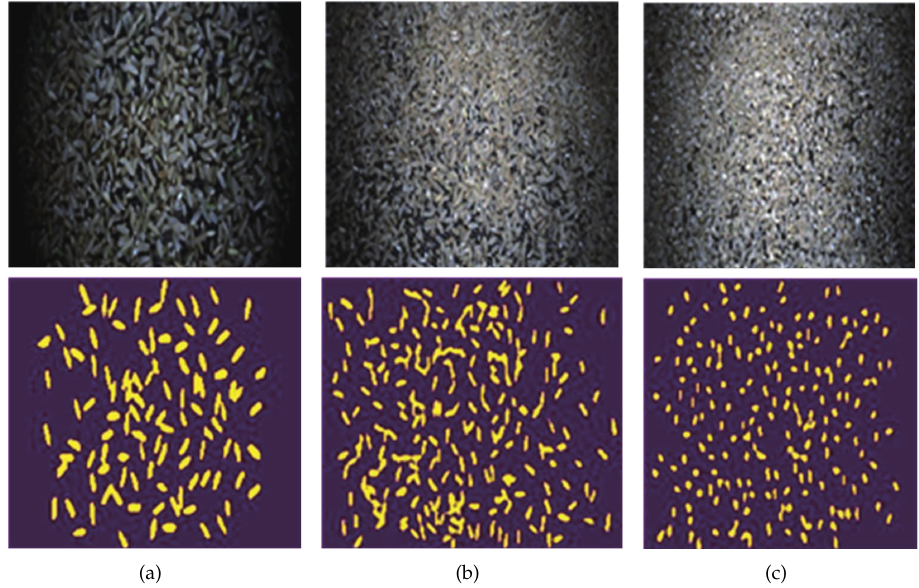
Figure 12. Effect diagram of rice grain semantic segmentation: ( a ) long rice; ( b ) short rice; ( c ) round